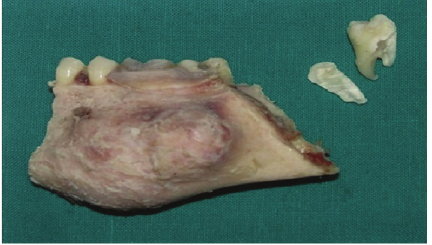
Figure 7: Excised specimen after segmental